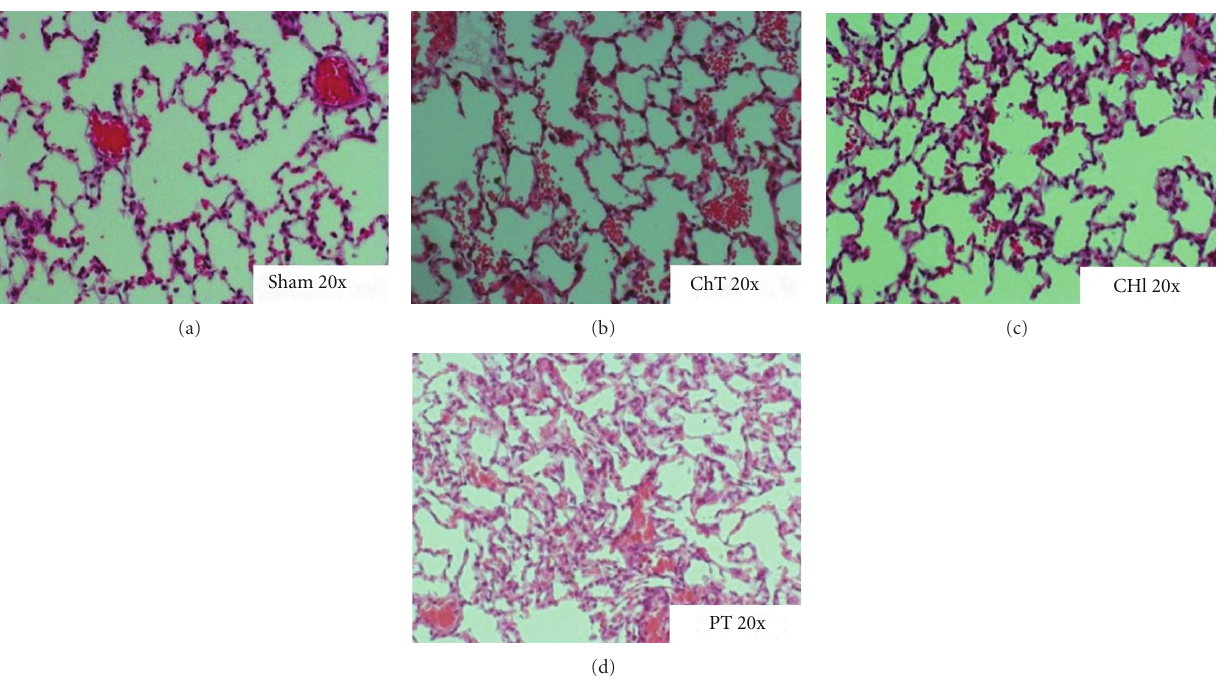
Figure 3: Histological changes in lung tissues after trauma, H&E stained lung tissue sections of Sham-, ChT-, CHI and PT-rats analysed by light microscopy with 20x